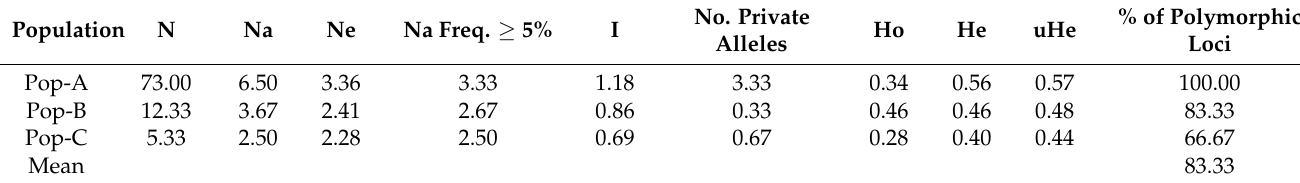
Table 5. Mean diversity indices of six D. rabiei SSR loci for three populations in Ethiopia.